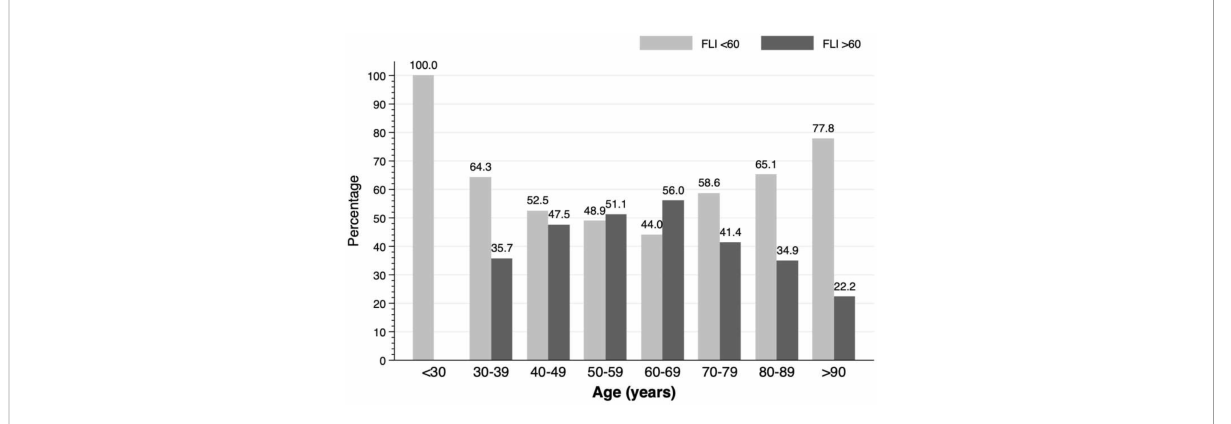
FIGURE 2 Prevalence of non-alcoholic fatty liver disease according to age decade in patients with a fi rst acute ischemic stroke.